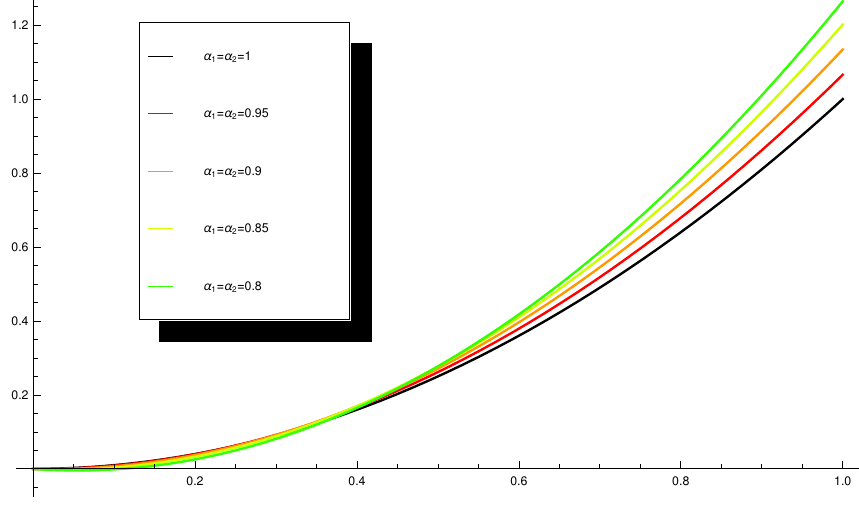
Figure 8. Approximate solutions x 2 of (20) for several values of α 1 and α 2